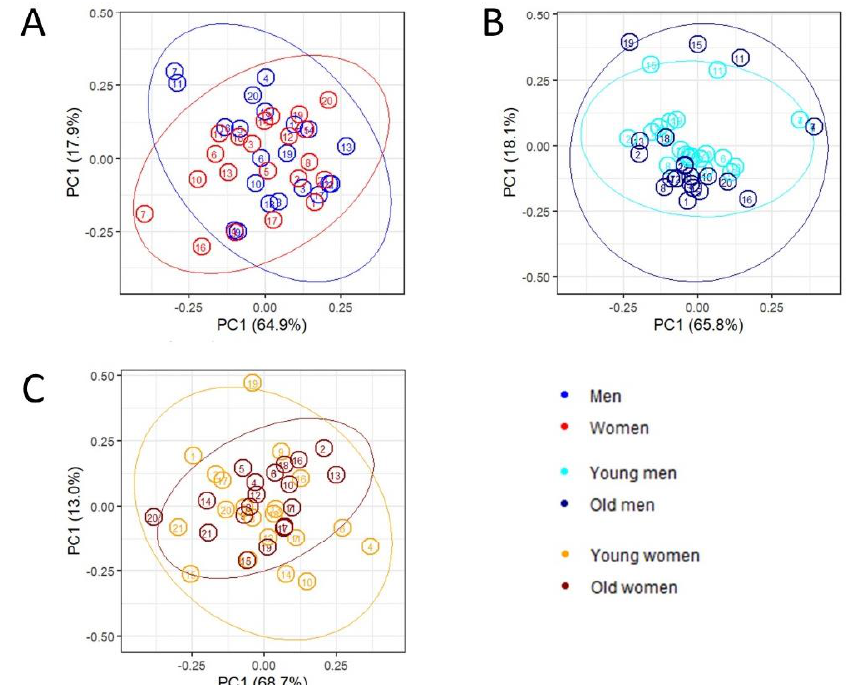
Figure 6. PCA of topological measures with ellipses for 95% confidence interval multivariate normal distribution. ( A ) between men (blue) and women (red). ( B ) between young (cyan) and old men (dark blue). ( C ) between young (orange) and old women (dark red). The lipoprotein main fractions are numbered as follow: 1: Apo-A1 HDL, 2: Apo-A2 HDL, 3: Apo-B VLDL, 4: Apo-B IDL, 5: Apo-B LDL, 6: Cholesterol VLDL, 7: Cholesterol IDL, 8: Cholesterol LDL, 9: Cholesterol HDL, 10: Free cholesterol VLDL, 11: Free cholesterol IDL, 12: Free cholesterol LDL, 13: Free cholesterol HDL, 14: Phospholipids VLDL, 15: Phospholipids IDL, 16: Phospholipids LDL, 17: Phospholipids HDL, 18: Triglycerides VLDL, 19: Triglycerides IDL, 20: Triglycerides LDL, 21: Triglycerides